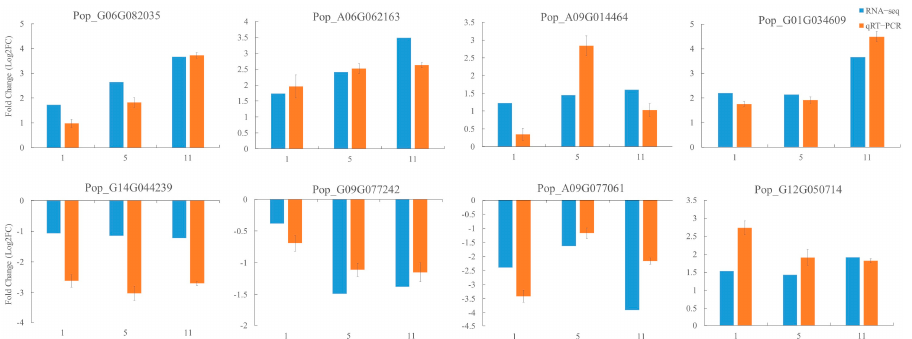
Figure 7. qRT − PCR validation of the transcriptome